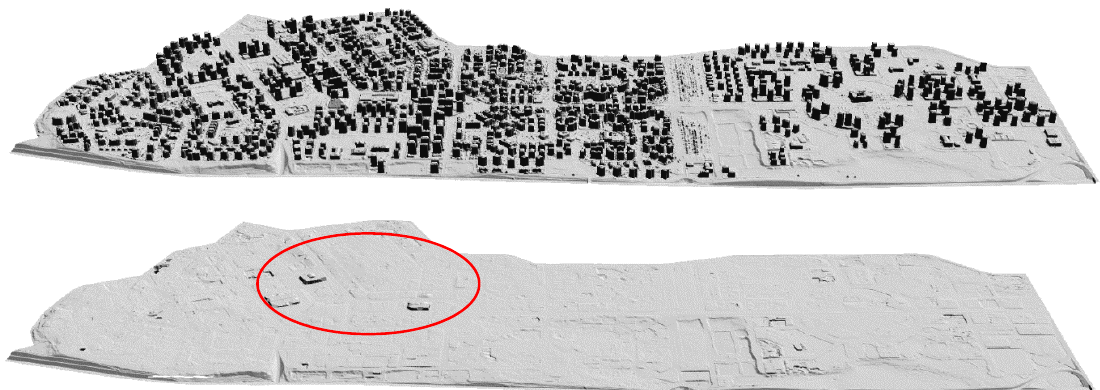
Figure 4. An overview of the generated digital surface model (DSM) and the digital terrain model (DTM), showing one area (red) with DTM filtering errors.